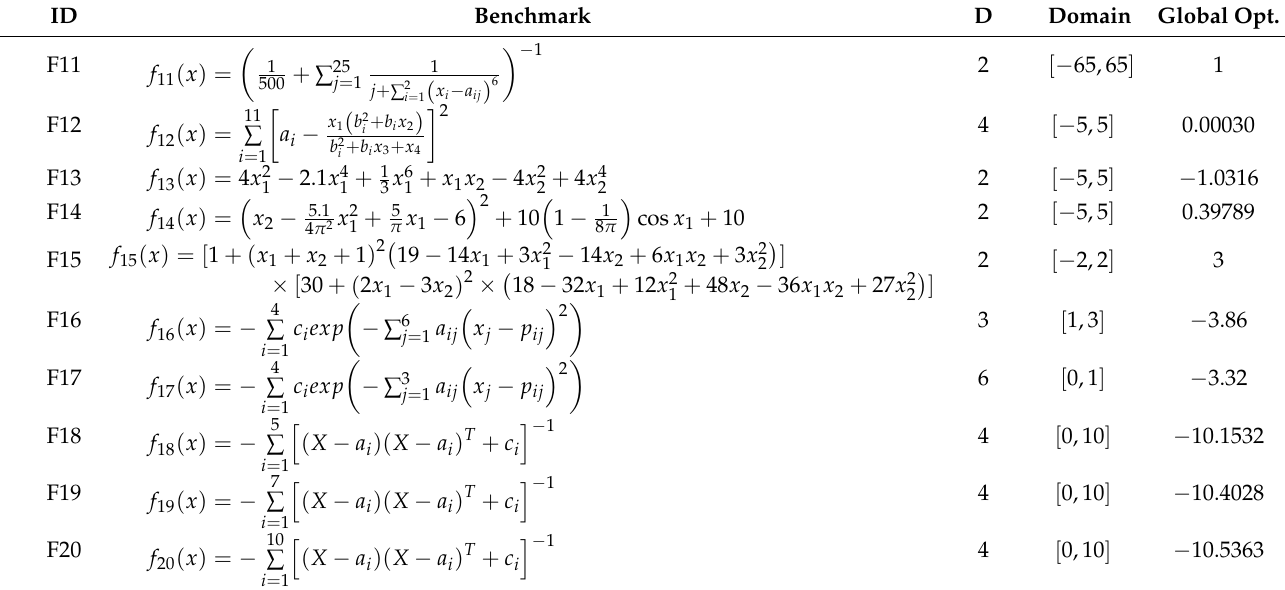
Table A3. Fixed-dimension multi-modal benchmark.